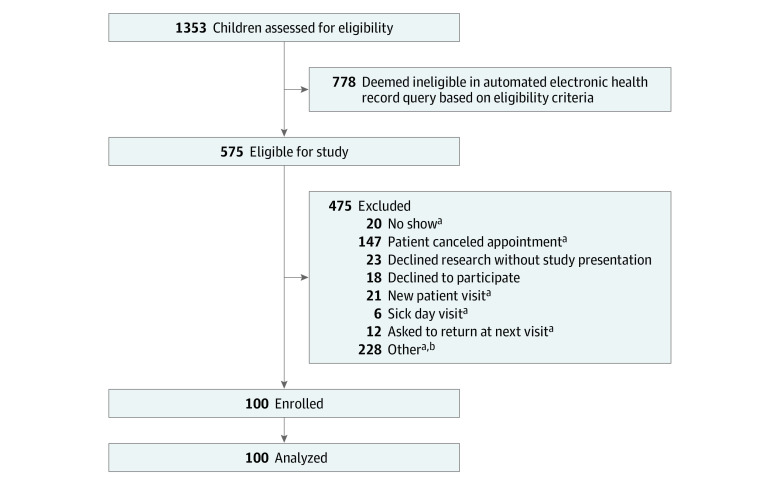
Screening, Eligibility, and Study Inclusion FlowchartaPatient was eligible to be reapproached.bIncludes medical team entered immediately, no research assistant available.